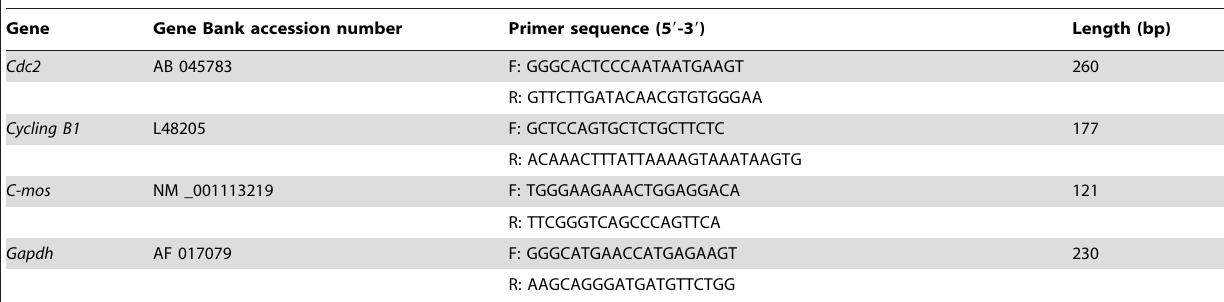
Table 1. Primer used for real-time